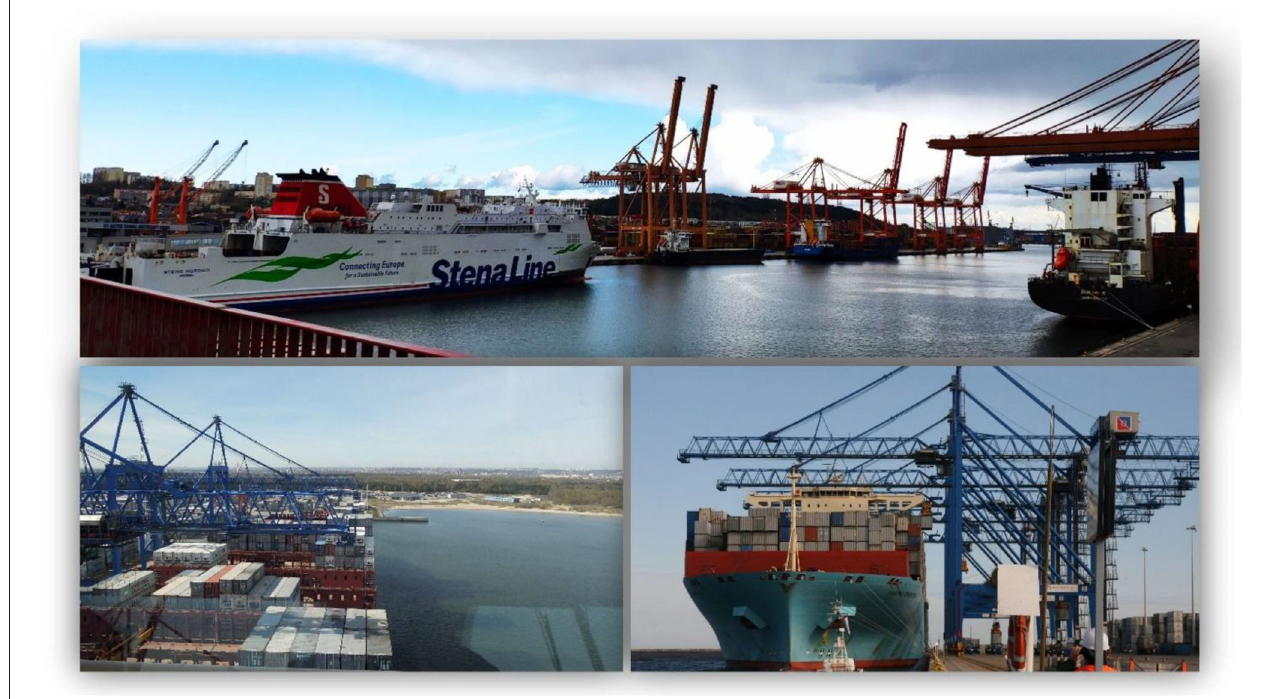
FIGURE 2 | (Top) Port of Gdynia and (bottom) Port of Gdansk (top photograph taken by Aneta I. Oniszczuk-Jastrz ˛ abek on 25 April 2021; bottom photographs taken by Ernest Czermañski on 7 March